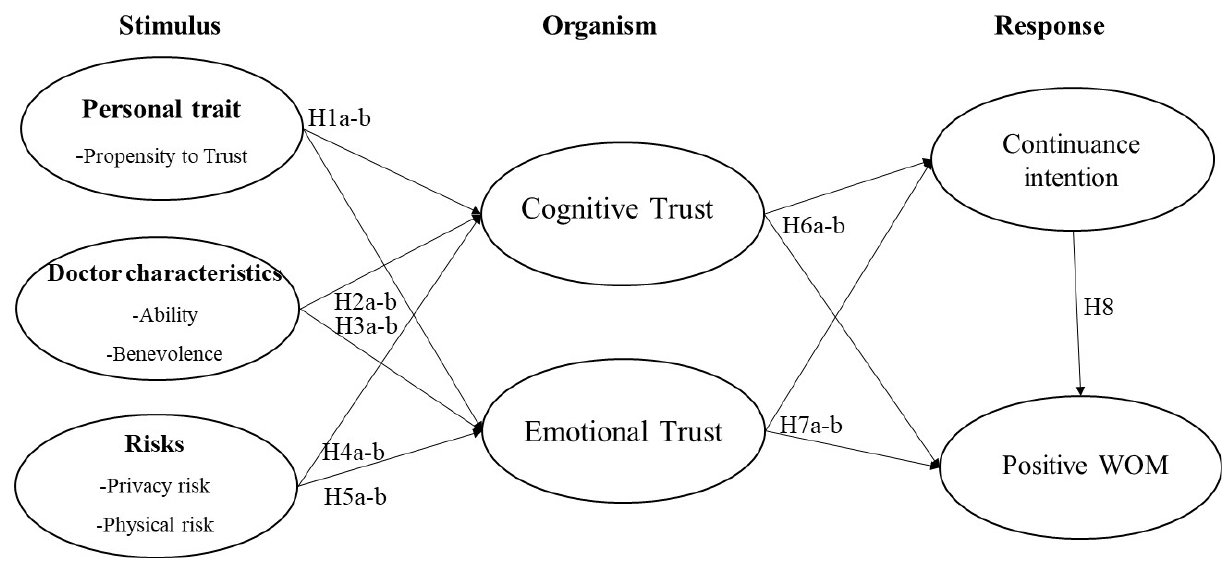
Figure 1. Research model.